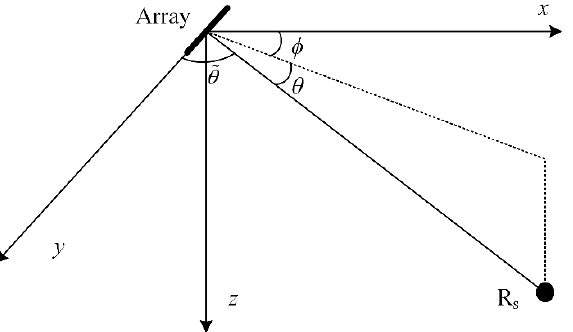
φ , beam angle θ  , and the grazing